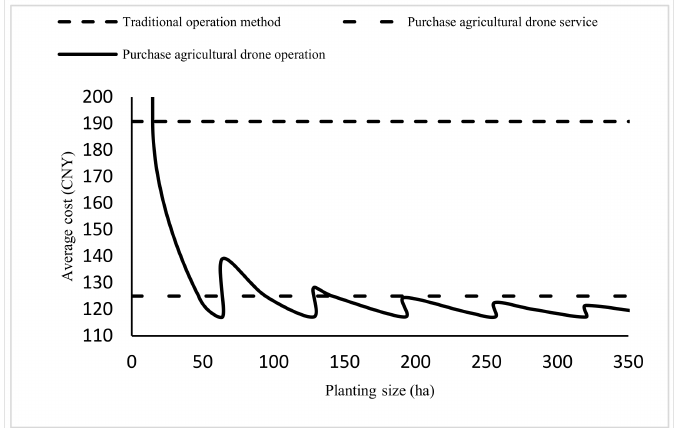
Figure 3. Effect of planting size on the average cost of plant protection and topping.